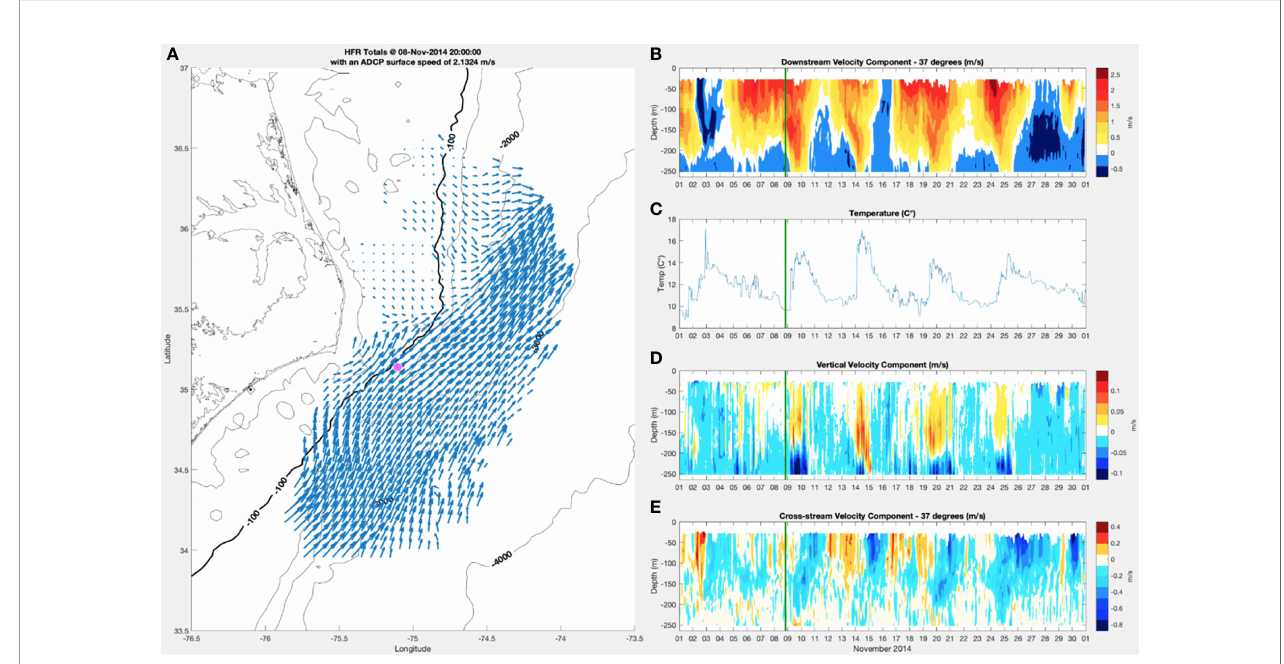
FIGURE 7 | Left: HFR surface currents (A) on November 8 at 20:00 GMT, with ADCP location at red asterisk, Right: ADCP downstream velocity contour (B) , bottom temperature (C) , vertical velocity contour (D) , and cross-stream velocity contour (E) , with green vertical line at November 8 at 20:00 GMT. See Event_1_.m4v for movie of meander passage from November 4 at 20:00 GMT to November 11 at 20:00